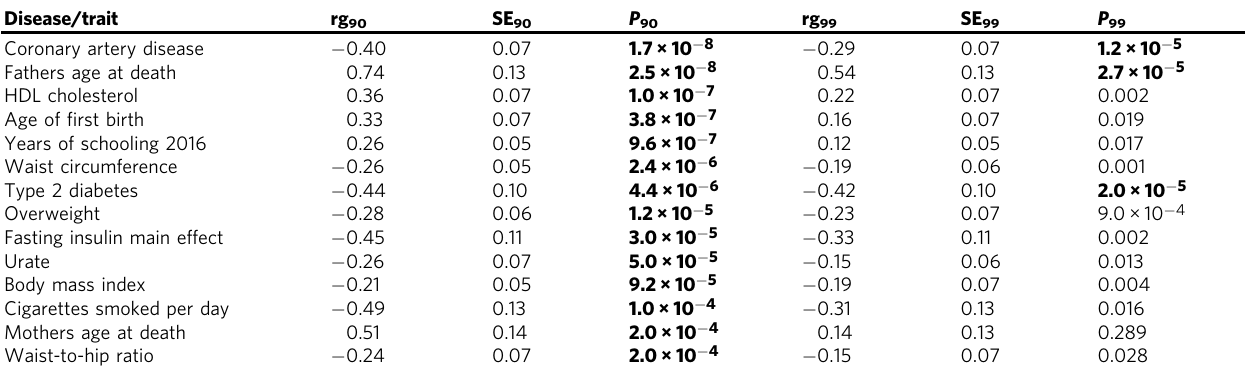
P -values highlighted in bold are signi fi cant after Bonferroni adjustment for multiple testing ( P <0.05/246). rg 90 , SE 90 , and P 90 are based on the analysis of the 90th percentile cases versus all controls meta-analysis data set, while rg 99 , SE 99 , and P 99 are based on the analysis of the 99th percentile cases versus all controls meta-analysis data set rg genetic correlation, SE standard error of the rg estimate, HDL high-density